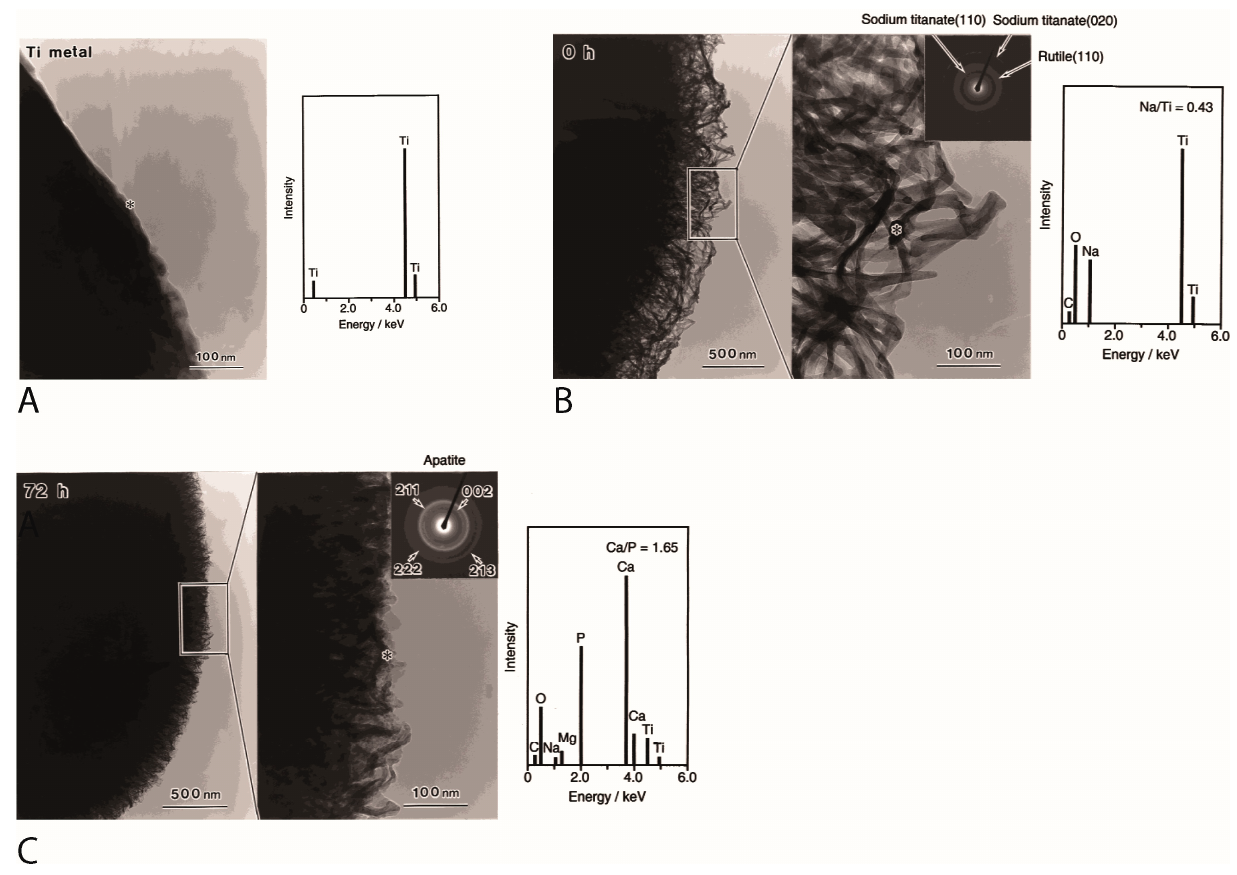
Figure 4. Functionalization of Titanium surfaces with hydroxyl (OH − ) groups enhanced nucleation of bone like apatite on the metal surface when it is submerged in physiological solutions. The figure shows transmission electron microscopy (TEM) images and energy dispersive X-ray spectrometry (EDX) results of titanium surfaces treated with NaOH and heat followed by immersion in physiological solution. ( A ) Titanium surface before NaOH and heat treatment; ( B ) Titanium surface after NaOH and heat treatment. Note the layer of amorphous sodium titanate that forms on the titanium surface; and ( C ) NaOH and heat-treated titanium surface after 72 h immersion in physiological solution. Note the deposition of natural apatite on the implant surface. * Center of electron diffraction and EDX analysis. Reprinted from [62] with permission from John Wiley & Sons, Inc., Copyright